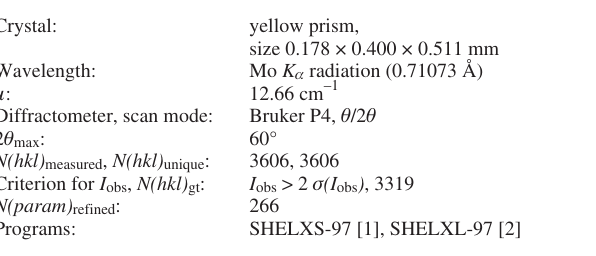
Table 1. Data collection and handling.